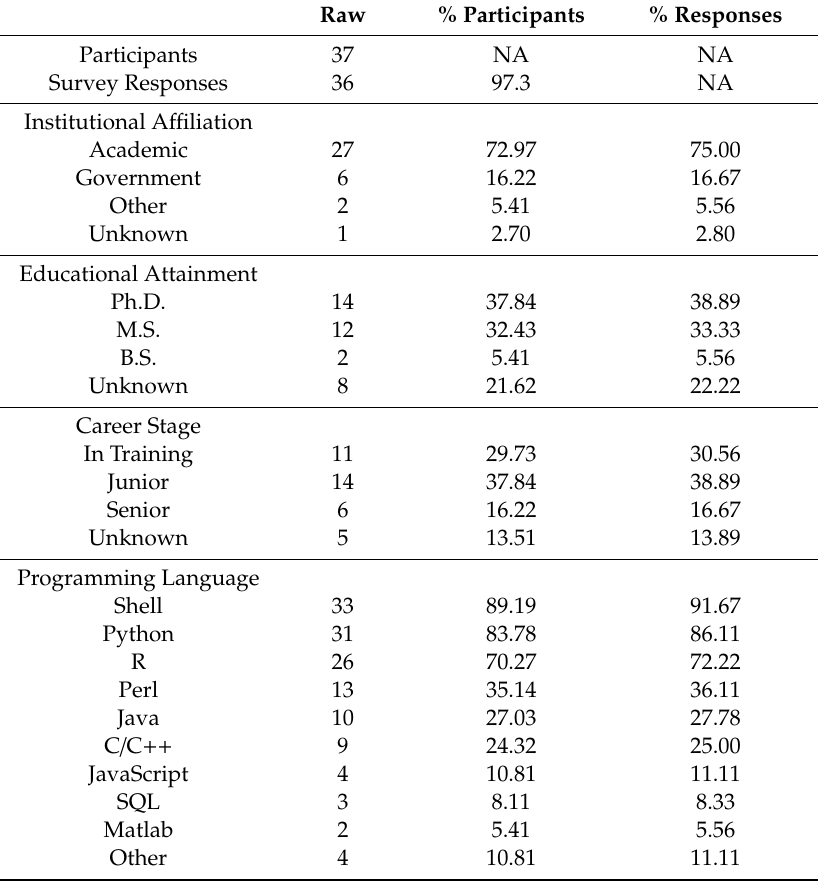
Table 1. Participant Demographics. Demographic summary of hackathon participants. Raw % Participants %